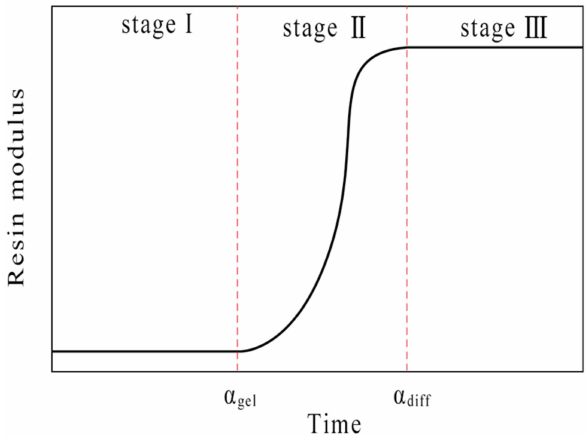
Figure 1. Resin modulus during